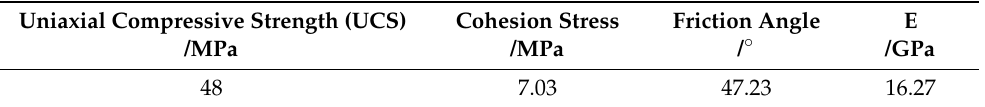
Figure 9. Enlarged apparent structure of the red sandstone (original magnification 200 × ). Table 3. Basic mechanical properties of red